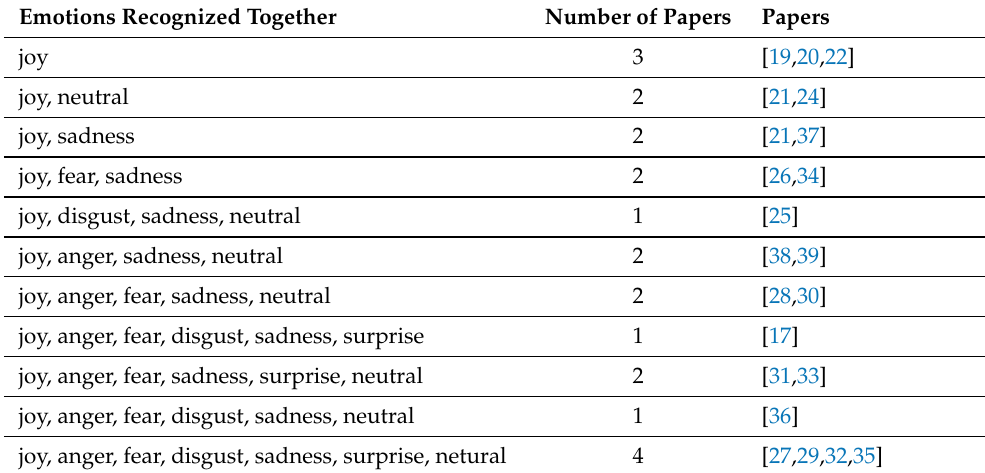
Table 4. Ekman emotions enriched with neutral emotion recognized together.